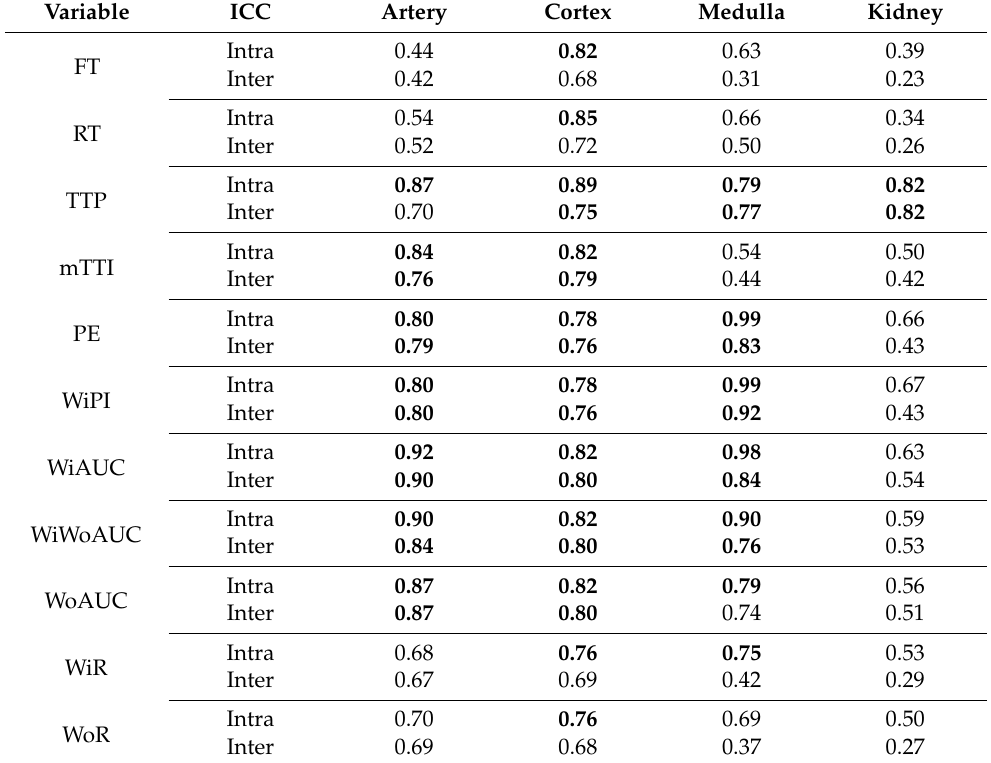
Table 1. Mean intra- and inter-observer agreement for measurement of contrast-enhanced renal perfusion